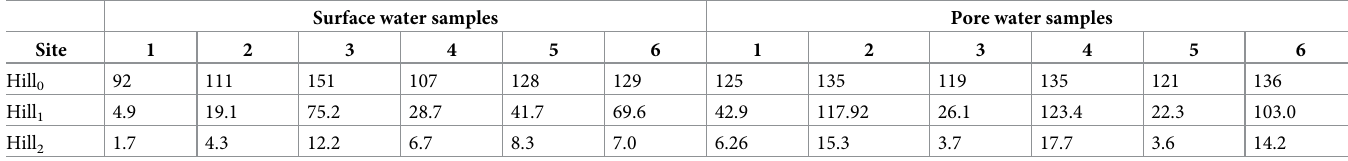
Table 1. Hill numbers of diversity indices calculated for all sites in surface and pore water. Hill 0 represents the detected number of OTUs for each sample. Surface water samples Pore water